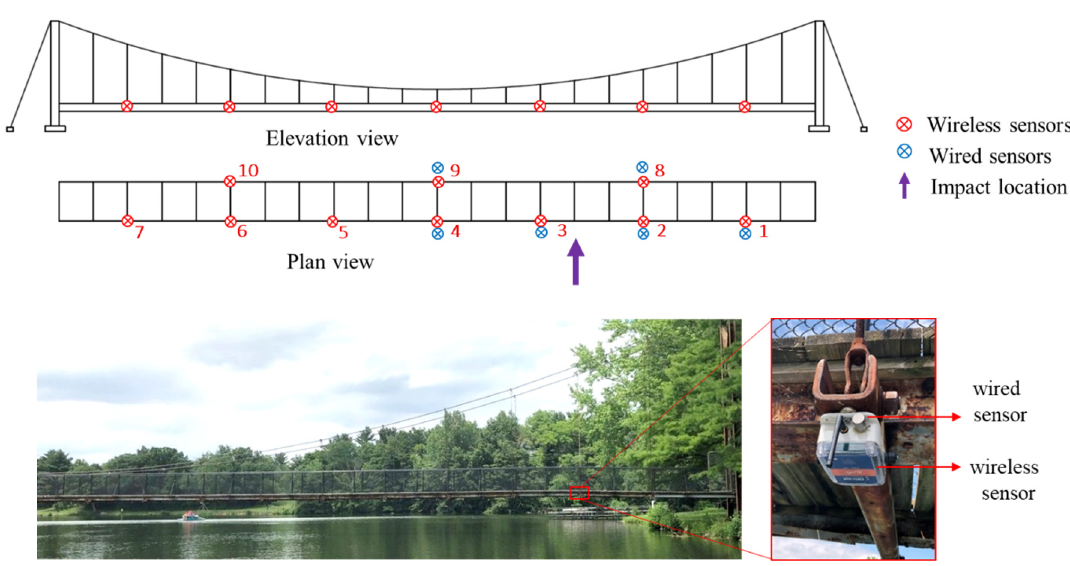
Figure 16. Sensor node deployment for bridge impact monitoring.